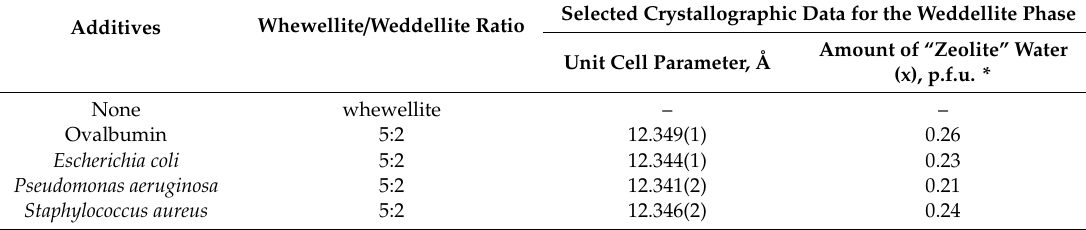
Table 4. Characteristics of phases synthesized within the oxalate system in the presence of bacteria and protein